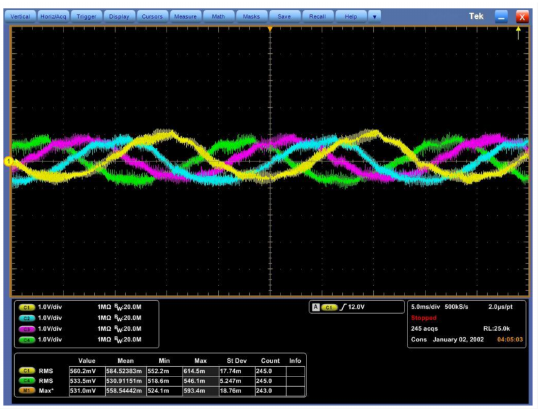
Figure 37. Measured motor phase currents in pentagon connection, no load